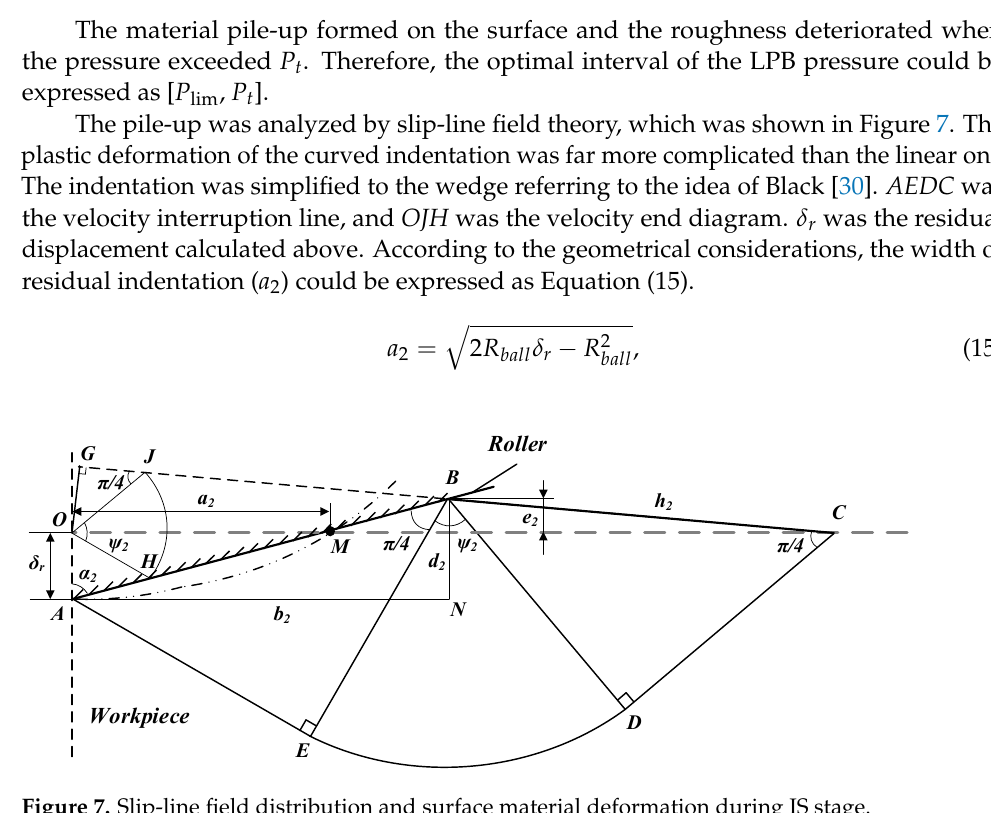
Figure 7. Slip-line field distribution and surface material deformation during IS Figure 7. Slip − line field distribution and surface material deformation during IS stage.